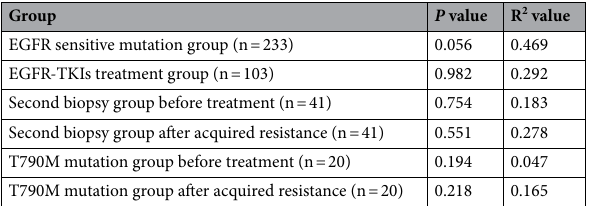
Group EGFR sensitive mutation group (n =